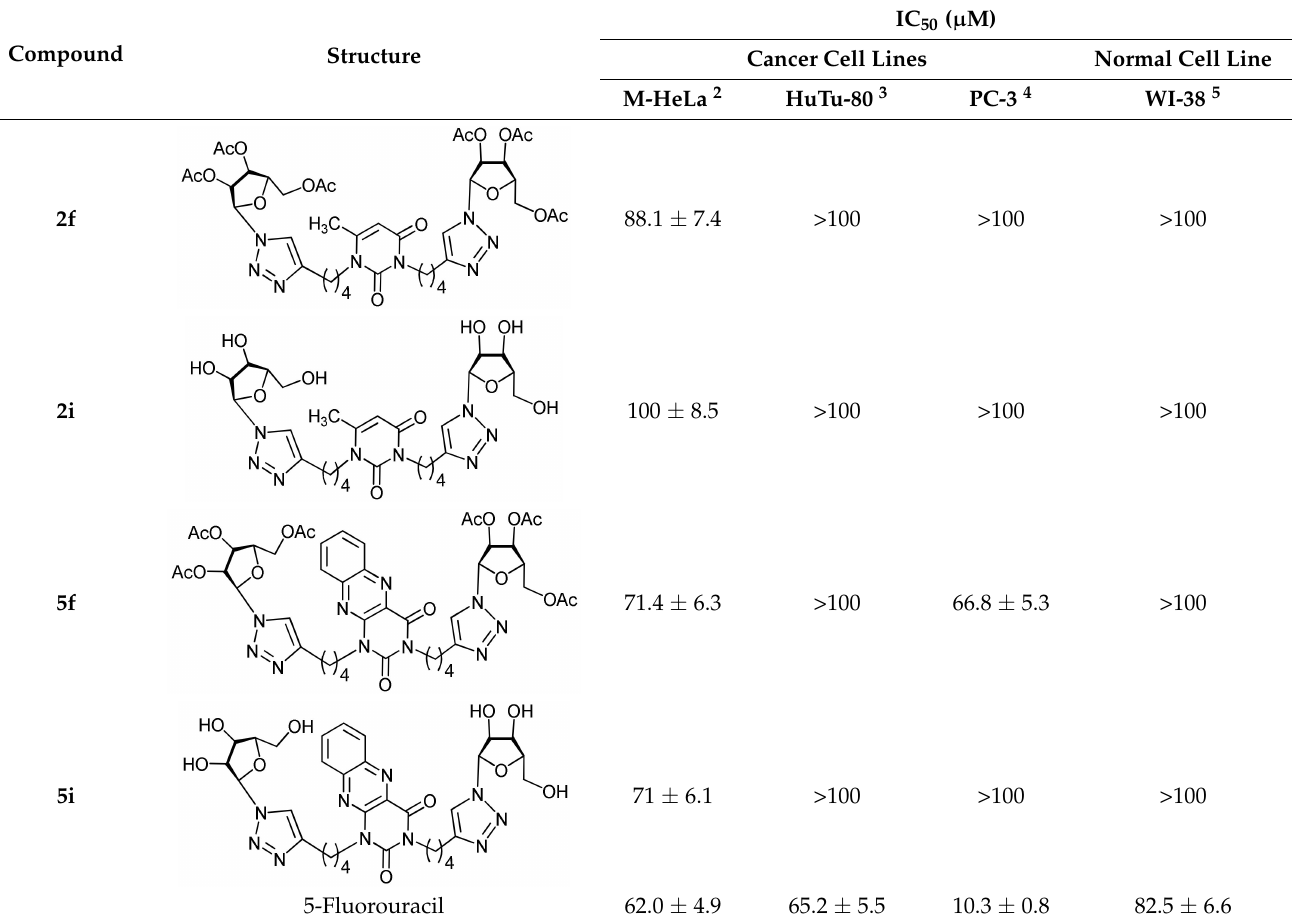
Table 3. Cytotoxic activity of several 1,2,3-triazolyl nucleoside analogues against human cancer and normal human cell lines (IC 50 values in µ M with standard errors) 1